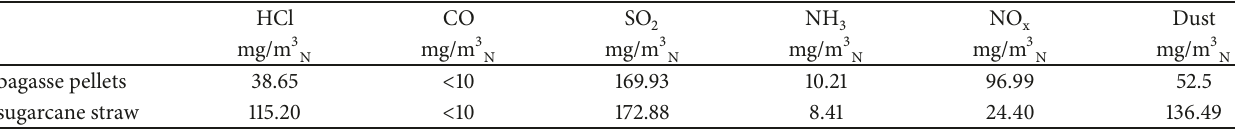
Table 5: Averaged emission levels at 11 % O 2 from a grate furnace of 440 kW. Duration of the experiment: approx. 40